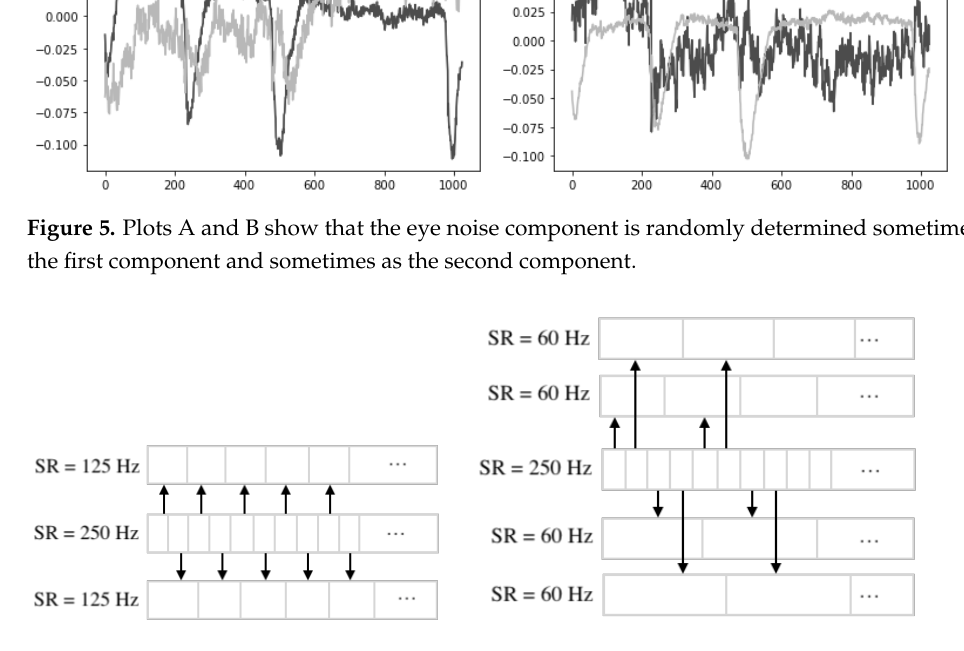
Figure 6. Downsampling from 250 Hz to 125 Hz and downsampling from 250 Hz to 62.5